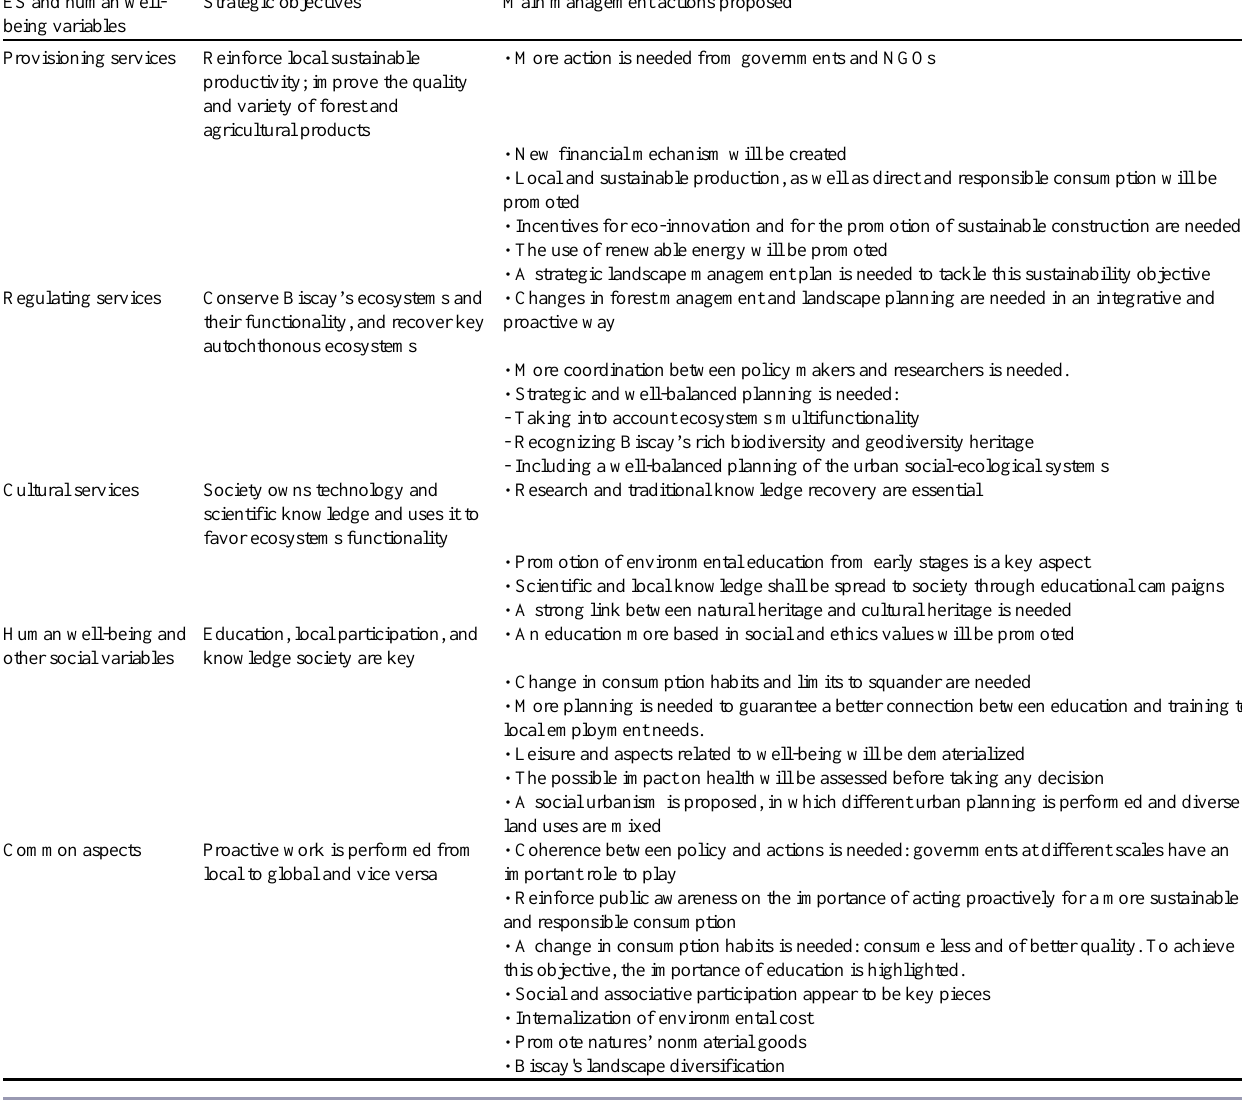
Table 2 . Strategic objectives and main management actions proposed by participants for the Biscay social ecological system regarding the ecosystem services and human well-being variables. Common aspects are shown separately. ES = ecosystem